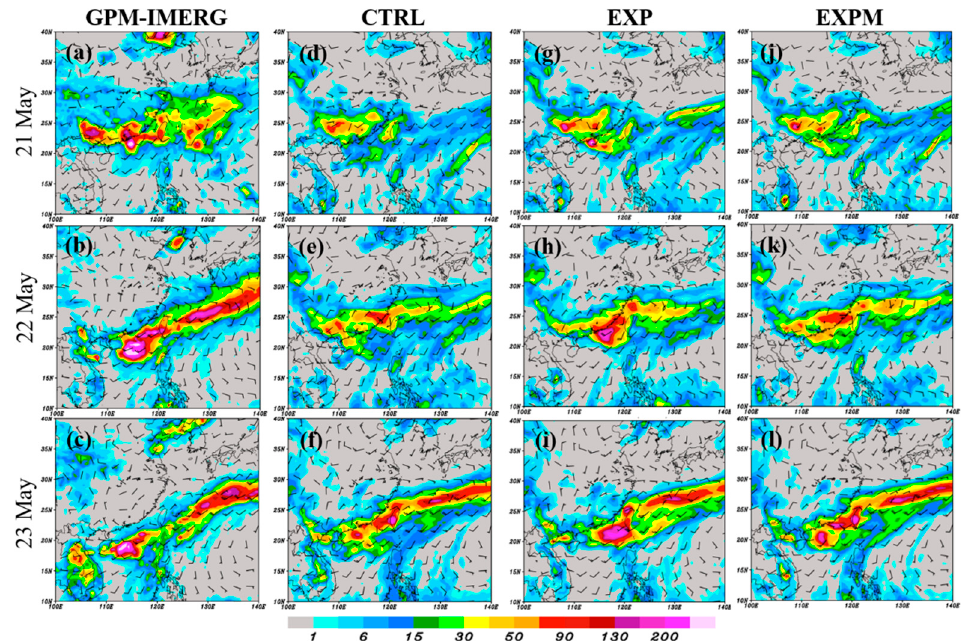
Figure 1. Daily precipitation (mm; shaded) in ( a ) 21 May, ( b ) 22 May, ( c ) 23 May 2020 from GPM- IMERG rainfall data. The 48–72 h accumulated rainfall from the forecast validated in ( d ) 21 May, ( e ) 22 May, ( f ) 23 May for the CTRL experiment. ( g – i ) and ( j – l ) as in panels ( d – f ), except for EXP and EXPM experiments, respectively.